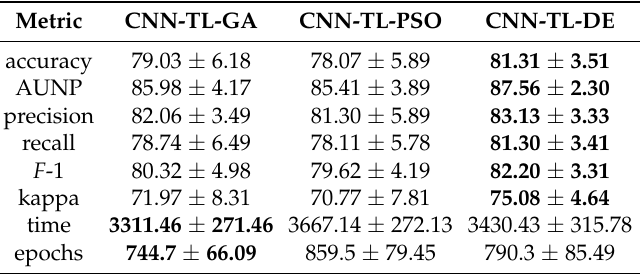
Table 6. Comparison of classification performance results with alternative optimization